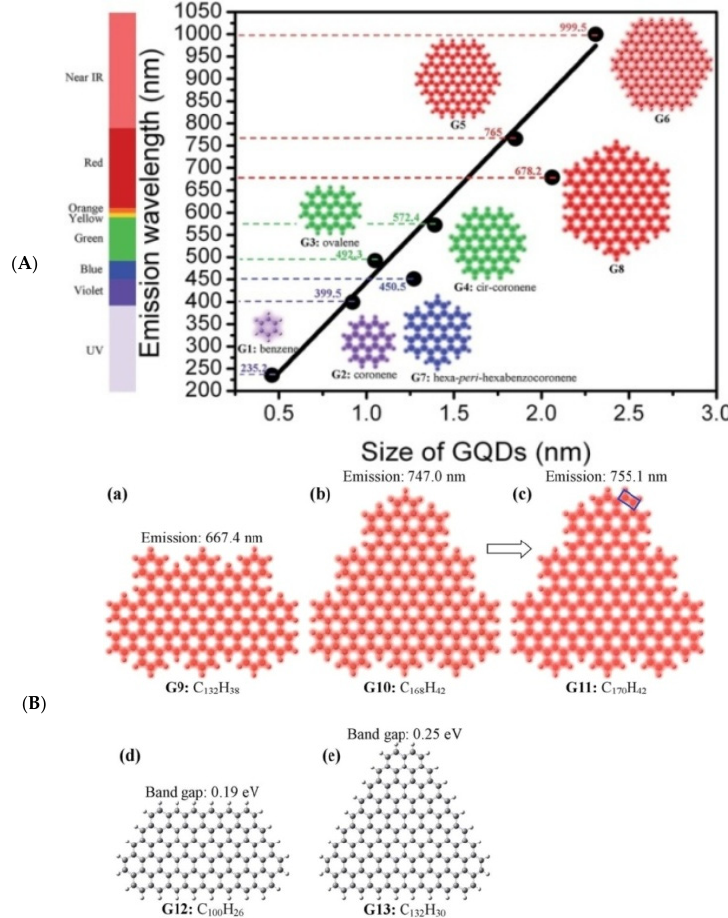
Figure 2. ( A ) Calculated emission wavelength (nm) using the time-dependent density functional (TDDFT) method in vacuum as a function of the diameter of GQDs. ( B ) Structure of pristine ( a ) armchair-edged GQD (C 132 H 38 ), ( b ) armchair-edged GQD (C 168 H 42 ), ( c ) armchair-edged GQD (C 170 H 42 ), formed by inserting two additional carbons (marked by blue rectangle) on C 168 H 42 GQD, ( d ) zigzag-edged GQD (C 100 H 256 ), and ( e ) zigzag-edged GQD (C 132 H 30 ). Reprinted with the permission of Reference [60]. Copyright 2019 The Royal Society of